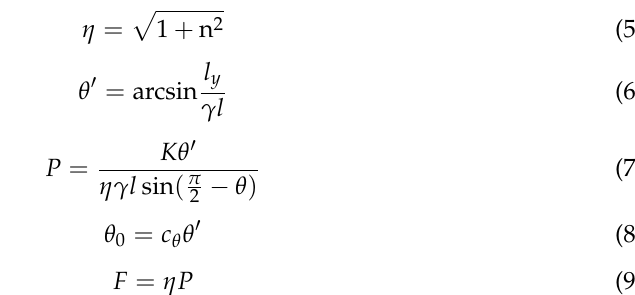
Figure 8. Left flexible finger.